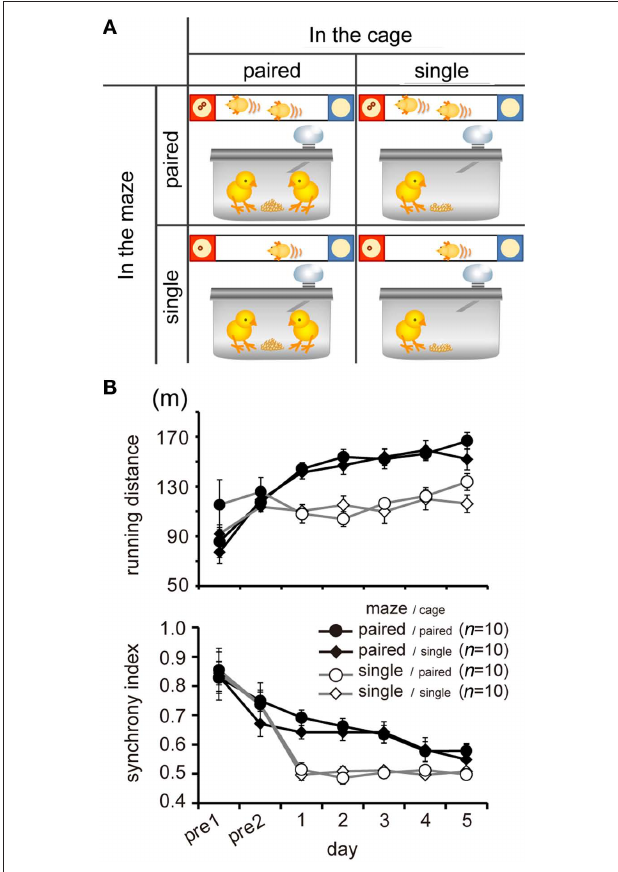
Figure 3 | Paired foraging in the maze, but not in the cage, influenced running (experiment 1). (A) Chicks were divided into four experimental groups according to 2 × 2 block placement. “In the maze” means chicks were single or paired in the I-shaped maze during the tests, whereas “in the cage” means that chicks foraged in single or paired condition in their home cage. Note that chicks were housed in pairs in all conditions except foraging. (B) Means ( ± SEM) of running distance (upper) and synchrony index (lower) during feeding time (ca. 8 min) are plotted against the day of the experiment. Open and filled symbols denote paired and single foraging in the maze, whereas circles and rhombi denote paired and single foraging in the cage, respectively, in this and the following figures.